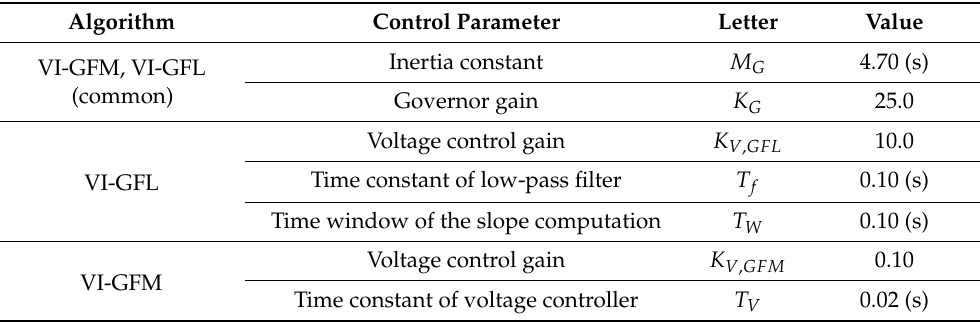
Table 3. Control parameters of